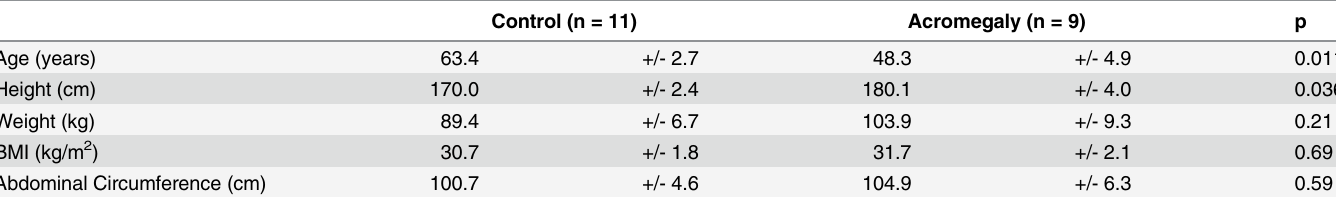
Table 1. Clinical